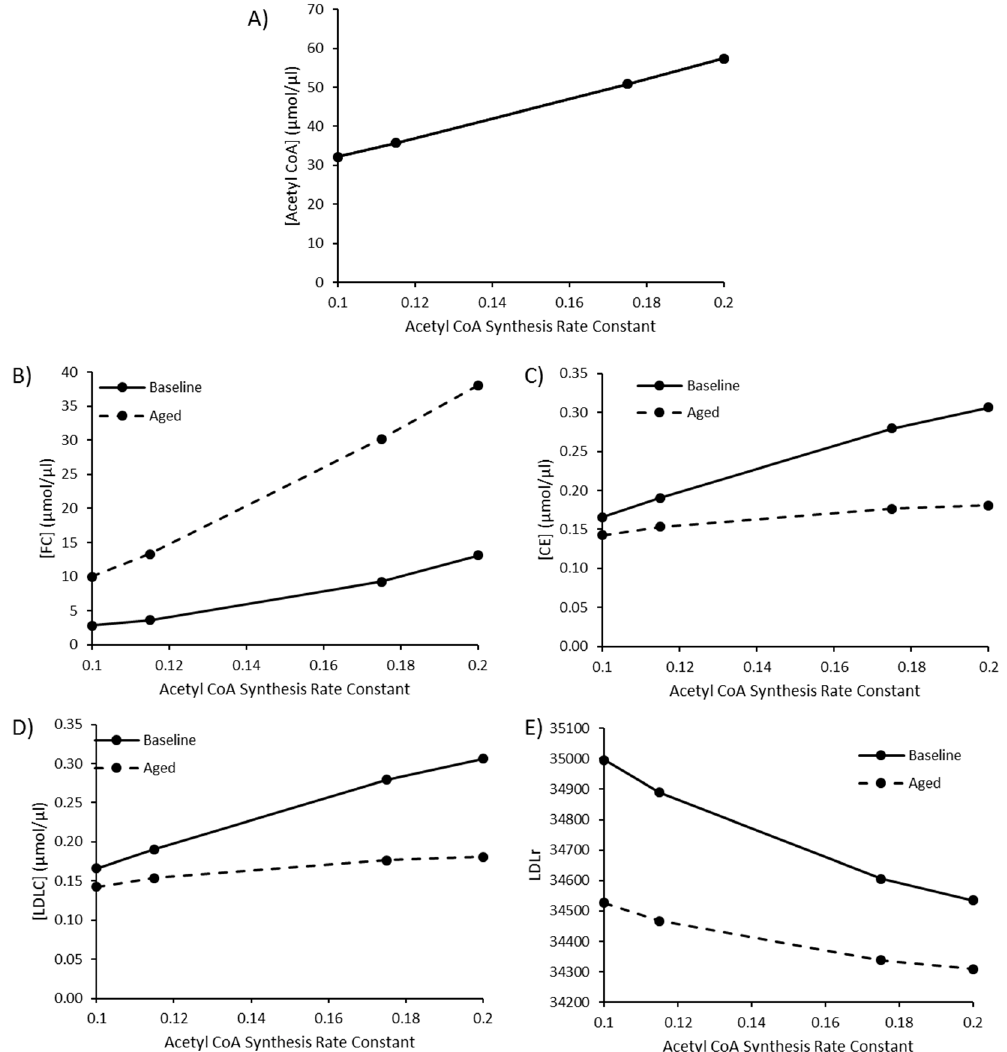
Figure 4. The combined effect of elevated acetyl CoA synthesis, as a representation of a high fat diet or comorbidity, and ageing on ( A ) [Acetyl CoA], ( B ) [FC], ( C ) [CE], ( D ) [LDLC], and ( E ) LDLr.